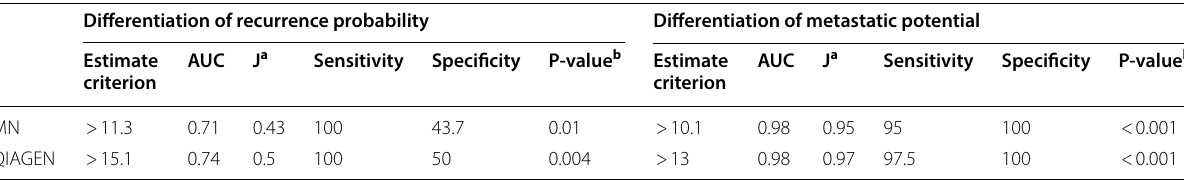
Table 4 The results of ROC curve